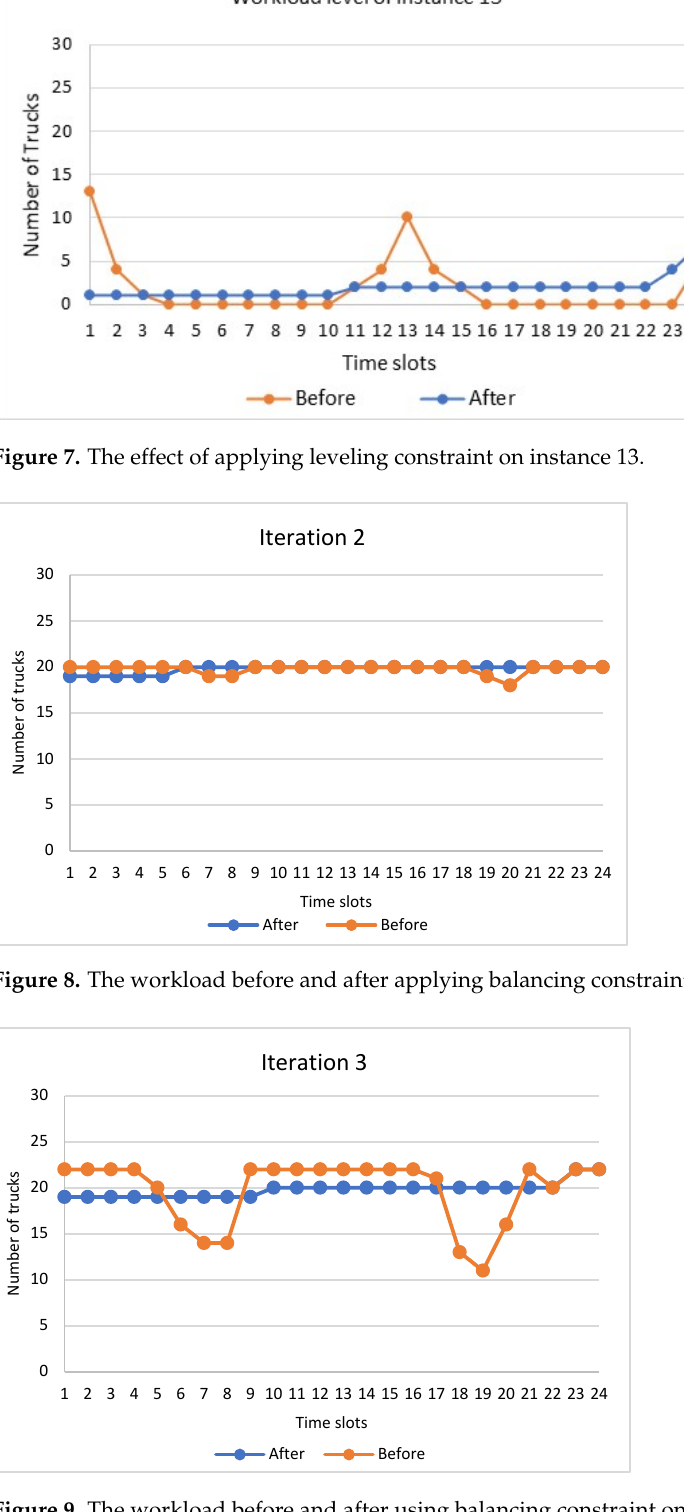
Figure 10. The workload before and after applying balancing constraint on iteration 4.